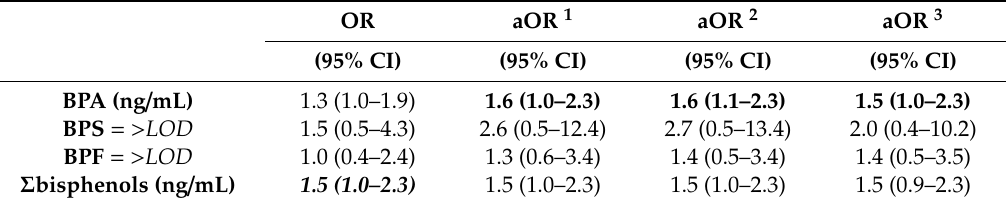
Table 3. Relationship between urinary bisphenols and endometriosis. Logistic regression analyses.